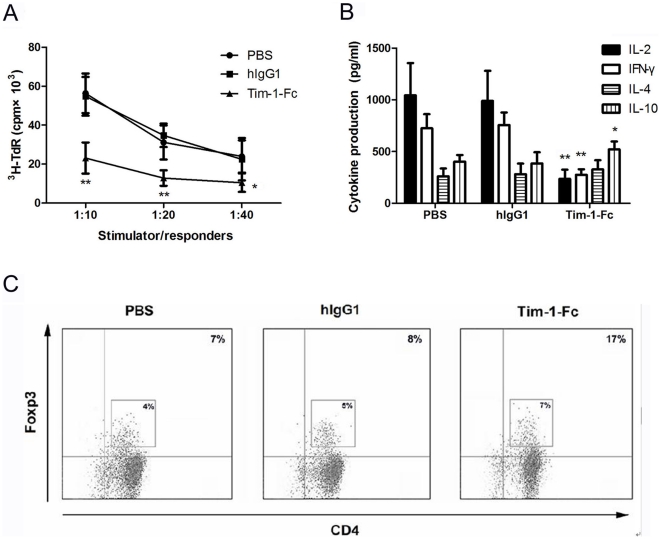
Tim-1-Fc induces hyporesponsiveness of CD4+ T cells to alloantigen and shifts the balance between Teffs and Tregs.CD4+ T cells (2×105/well) purified from C57BL/6 recipient treated with PBS, hIgG1 and Tim-1-Fc for 7 days were cocultured with BALB/C derived DCs at indicated ratios (1∶40, 1∶20, 1∶10) for 72 h. Cell proliferation and cytokines production were evaluated by 3H-thymidine incorporation (A) and ELISA (B). *P<0.05, ** P<0.01 in comparison with controls. (C) The proportion of CD4+Foxp3+ T cells in C57BL/6 recipient splenic CD4+ T cells was determined by FCM analysis. The frequency of Foxp3high and Foxp3low cells was labled. Data were representative of three experiments.